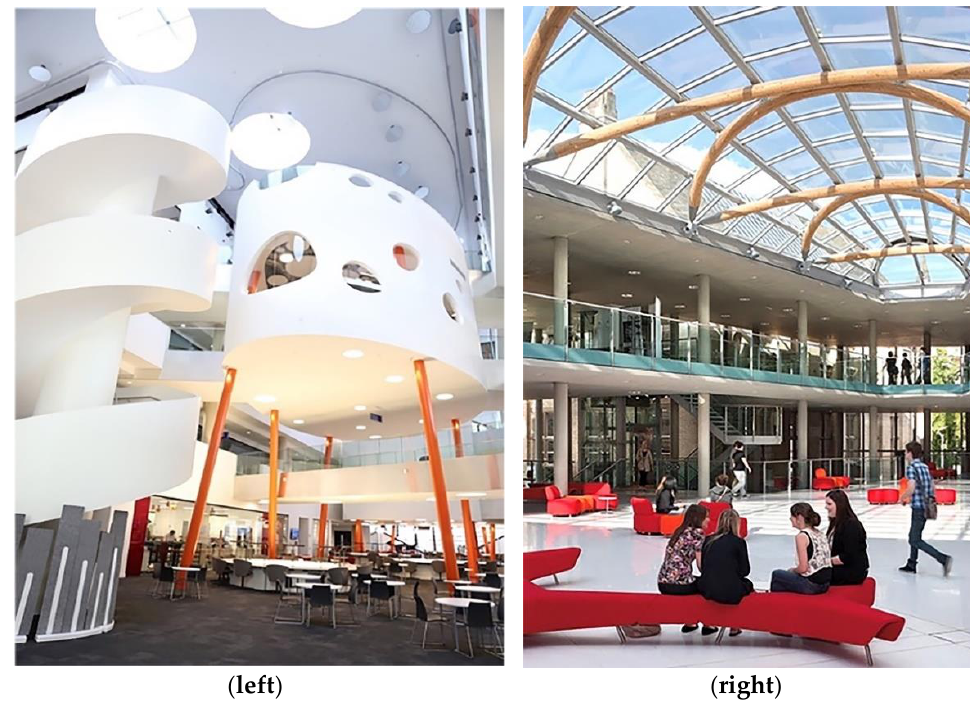
Figure 9. Openness of atrium in educational complexes of Diamond ( left ) and Newton ( right ).